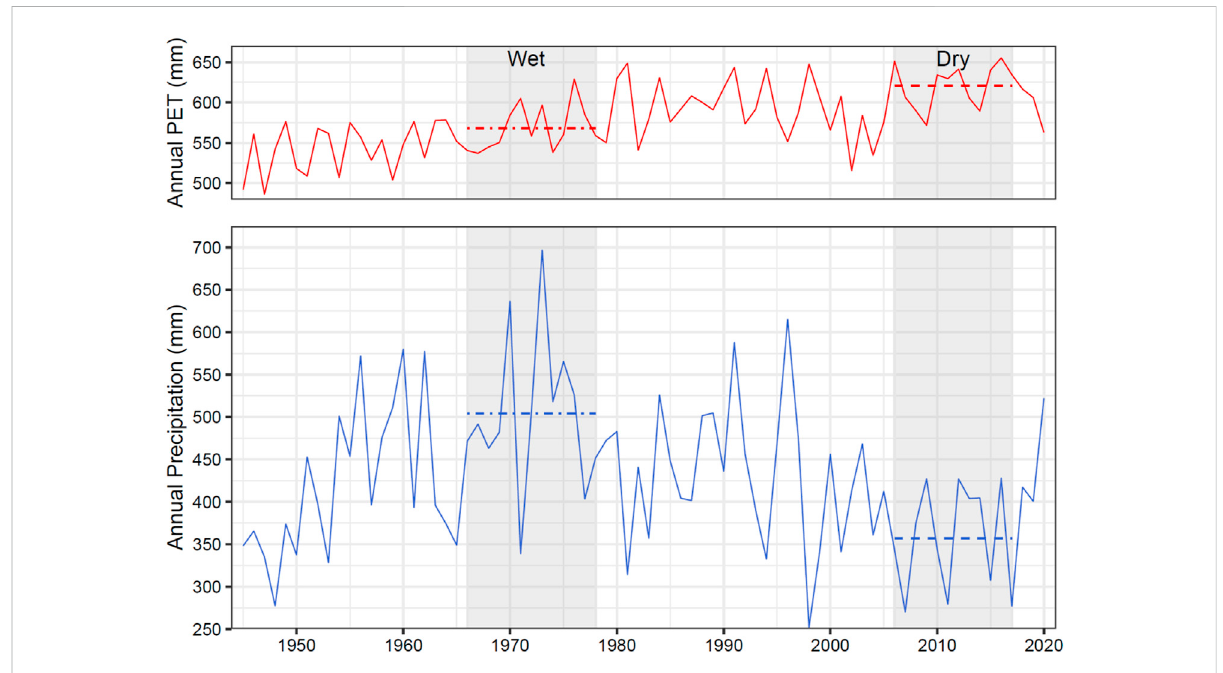
FIGURE 3 1944 – 2020 annual precipitation and PET at fort mcmurray airport climate station. The dashed lines show the average value for the wet and dry